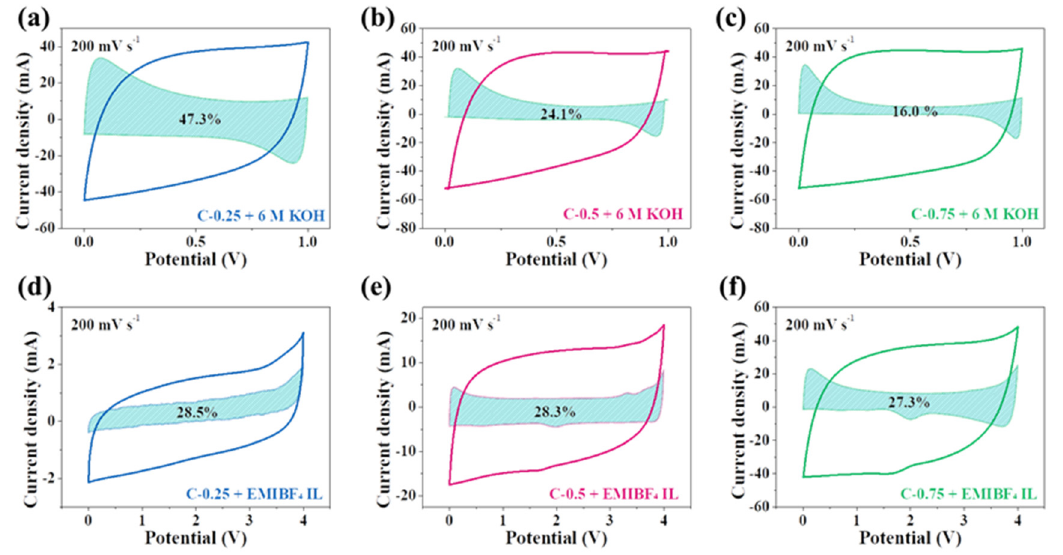
Figure 8. CV curves of ( a , d ) C-0.25, ( b , e ) C-0.5, and ( c , f ) C-0.75 in two kinds of electrolytes (6 M KOH and EMIBF 4 IL) tested in a two-electrode system at 200 mV s − 1 . The shadow areas represent the diffusion-controlled contribution.